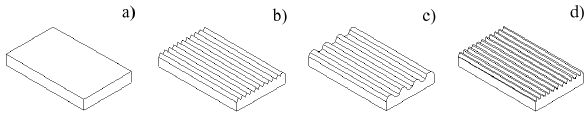
Figure 1: Profiles of crushing plates: a) flat, b) triangular, c) rounded, d)